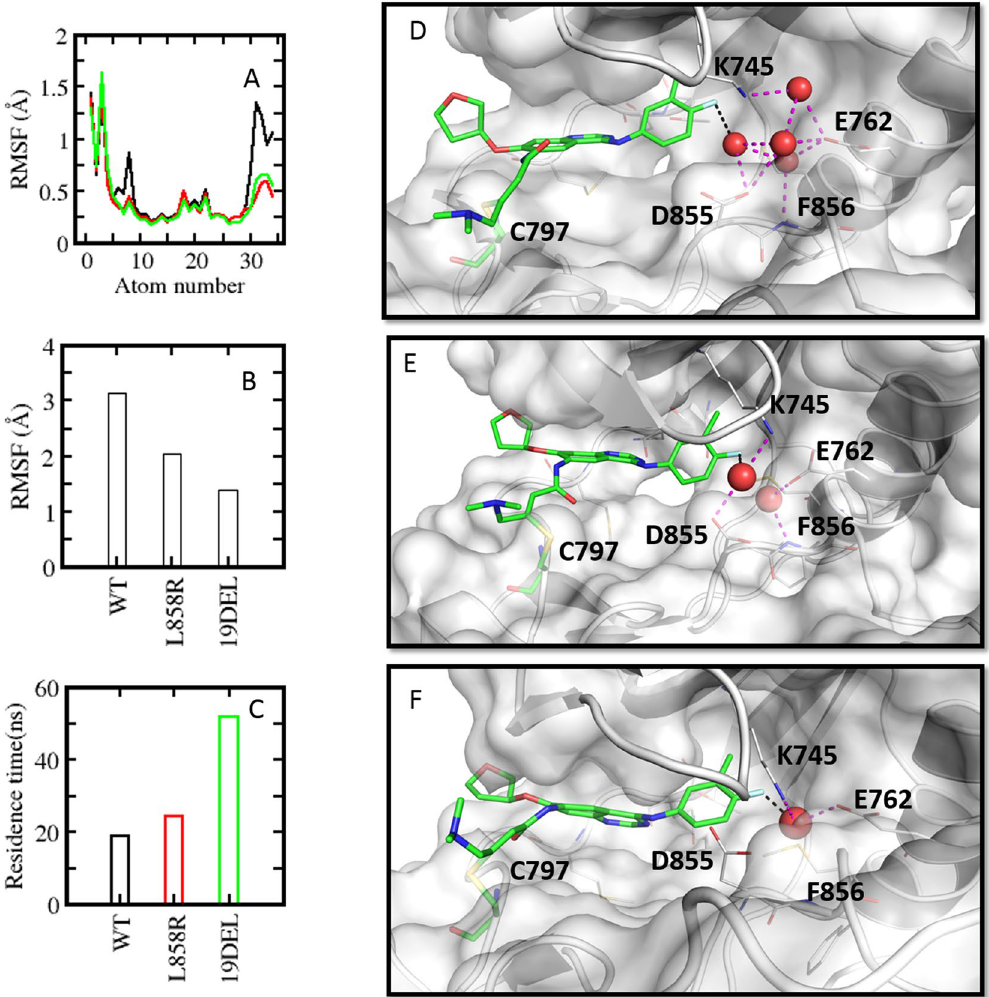
Figure 4. ( A ) Atomic root mean square fluctuations (rmsf) of afatinib bound to EGFR WT (black) EGFR L858R (red) EGFR 19del (green) sampled during the MD simulations. ( B ) rmsf of α C-helix sampled during the MD simulations of EGFR WT , EGFR L858R , EGFR 19del complexed with afatinib. ( C ) residence times of water molecules observed during the MD simulations of EGFR WT (black) EGFR L858R (red) EGFR 19del (green) complexed to afatinib. Water molecules observed between the inhibitors and α C helix of EGFR WT ( D ), EGFR L858R ( E ), EGFR 19del ( F ). Hydrogen bond (magenta) and halogen bond (black) interactions are shown as dotted